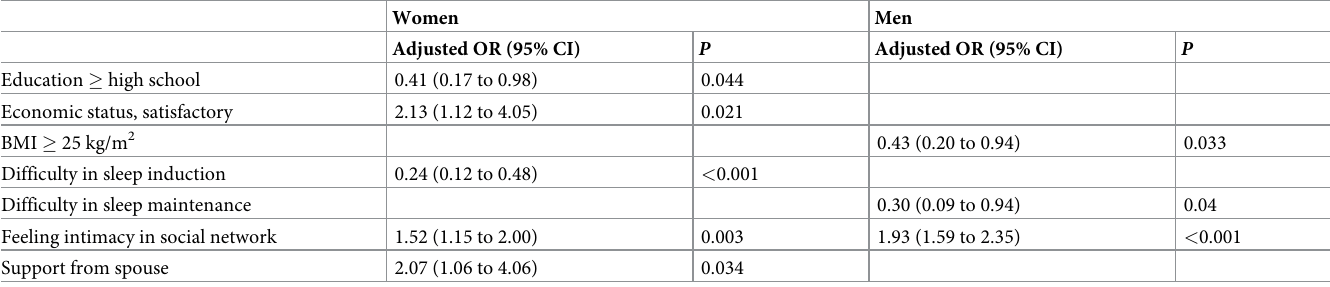
Table 3. Factors associated with total sleep time overestimation.